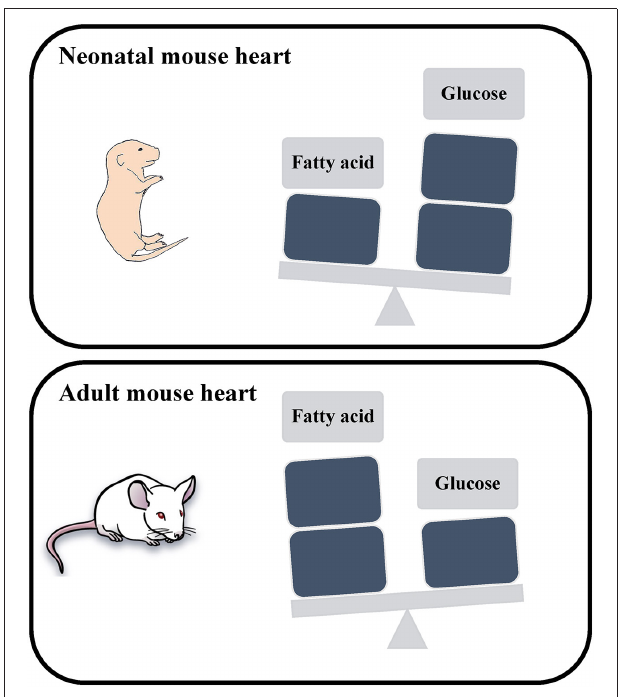
FIGURE 1 | Schematic representation of the energy utilization in neonatal and adult mouse hearts. The neonatal mouse heart generates energy through glucose metabolism, while the adult mouse heart generates energy through fatty acid